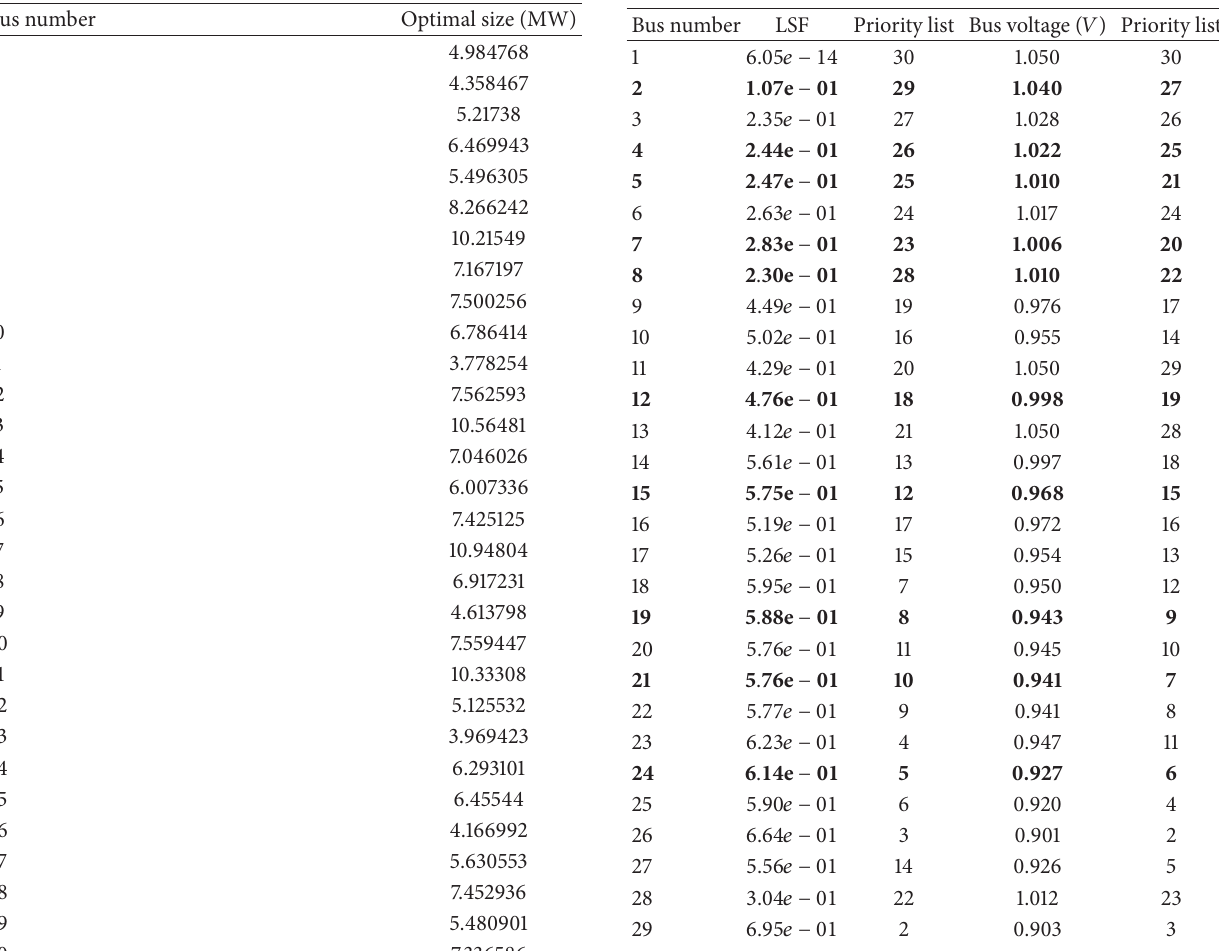
Table 1: Size of DGs from PSO. Table 2: Sequence of priority list by WK and LSF